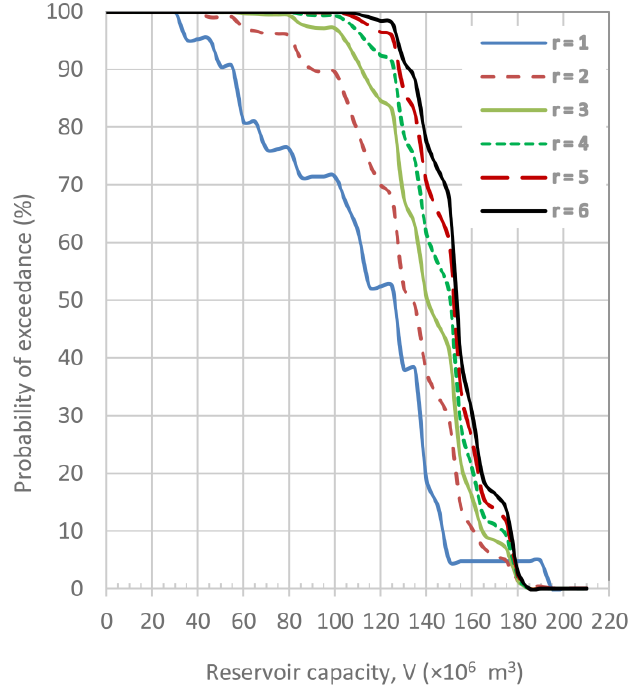
Figure 3. Probability of exceedance for any given reservoir capacity and for regulation periods from 1 to 6